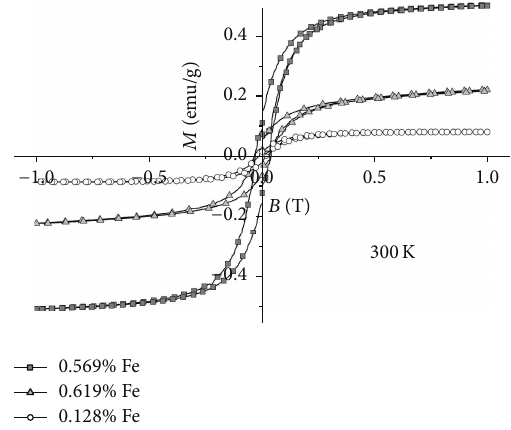
Figure 7: 𝑀 versus 𝐻 curves for ZnO-Zn-Fe NPs with various doping